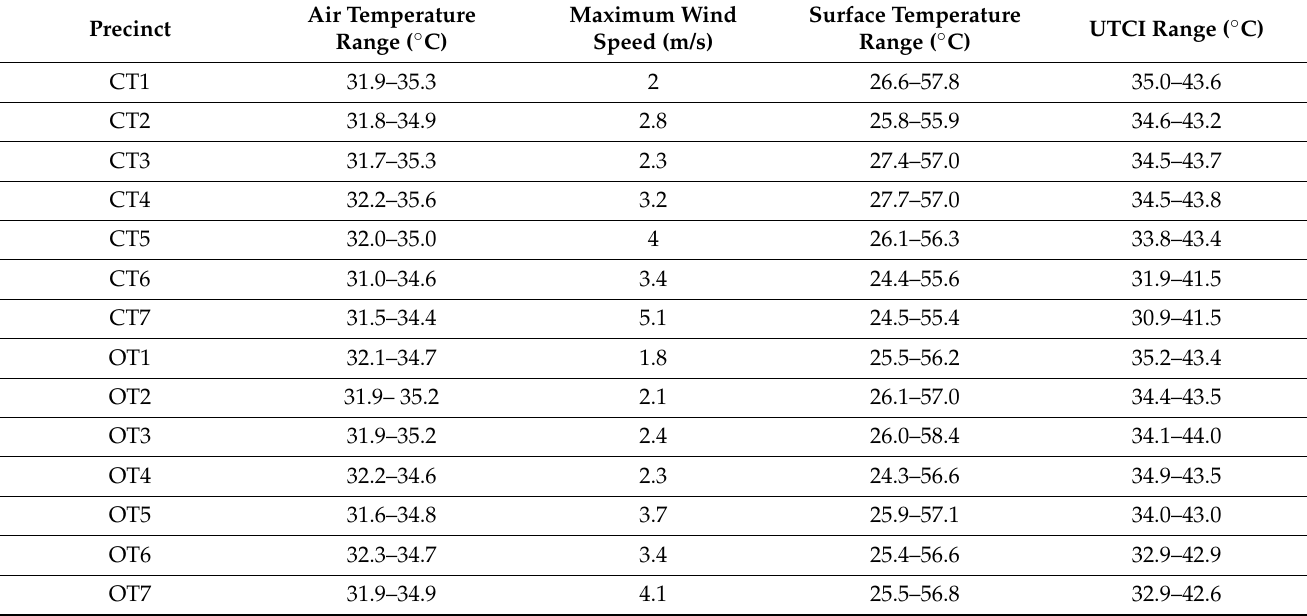
Table 9. The results of the unmitigated cases for